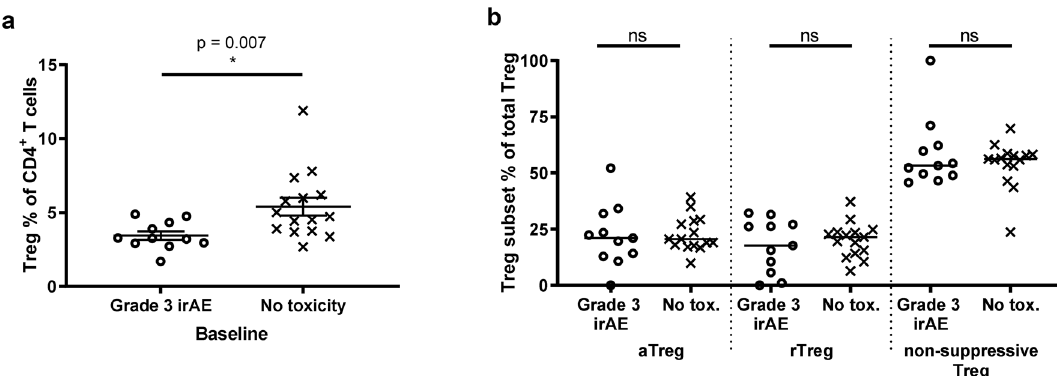
Figure 4. Patients who go on to have grade 3 irAEs have lower proportions of total Tregs at baseline. ( a ) Baseline Treg (CD25 + CD127 lo FoxP3 + ) proportion of CD3 + CD4 + lymphocytes in patients experiencing grade 3 irAE (n = 11) or no toxicity (n = 15). ( b ) Frequencies of Treg subsets at baseline: CD45RA - FoxP3 hi activated Treg (aTreg); CD45RA + FoxP3 lo resting Treg (rTreg); CD45RA - FoxP3 lo non-suppressive Treg cells. Mann–Whitney test; *p ≤ 0.05; error bars,